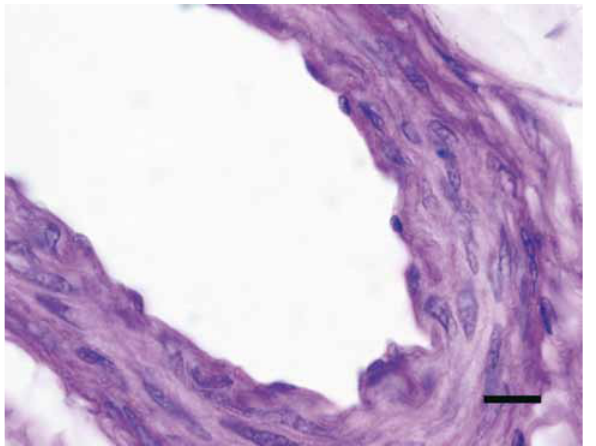
Figure 2 - Tunica intima of the DAP of a diabetic rabbit, showing cytoplasmic vacuolization (arrows) and nuclear protrusions (arrow heads) in the endothelium. Sections were stained with PAS stain, and images were taken at 1000x magnification. Scale bar: 10µm.